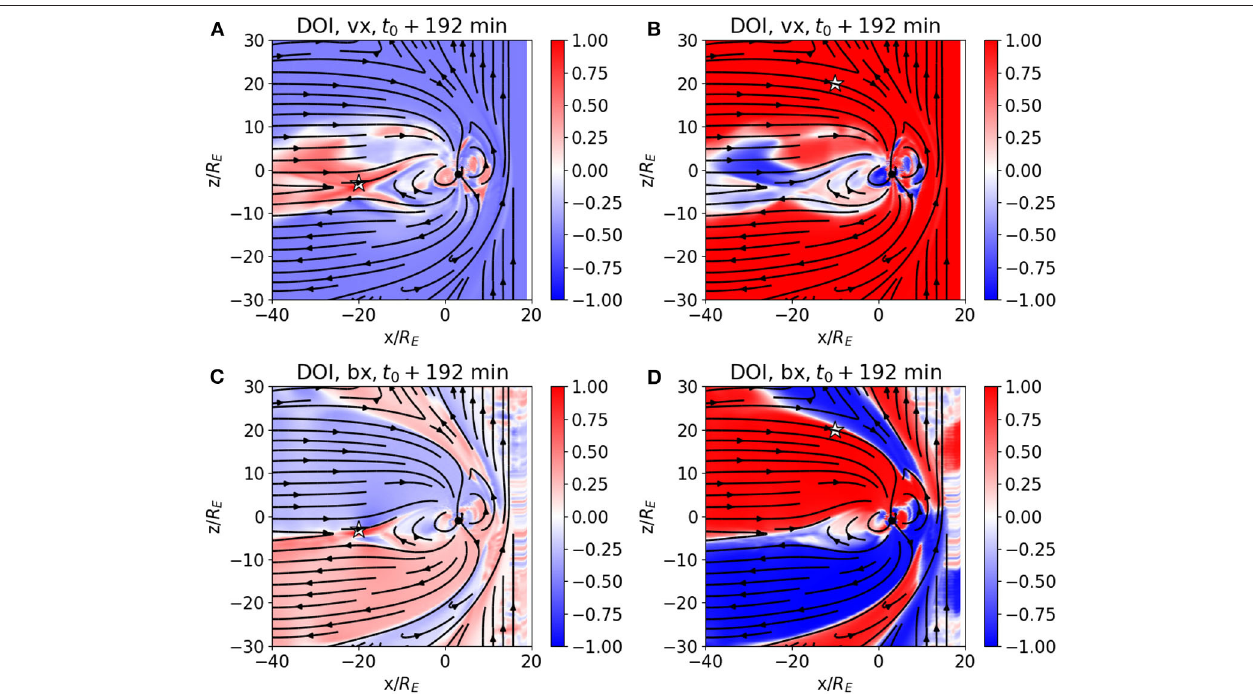
FIGURE 5 | DOI maps for v x (A,B) and B x (C,D) from an ensemble of OpenGGCM magnetospheric simulations with observation point in the plasma sheet (A,C) and in the magnetosheath (B,D) , at t 0 + 192 min. All previous Figures were at t 0 + 172